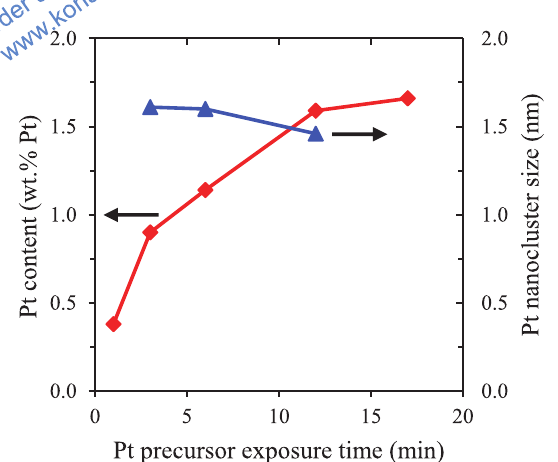
Fig. 8 Pt particle size distributions derived from TEM image processing for samples obtained after 3 min (white bars), 6 min (grey bars) and 12 min (black bars).